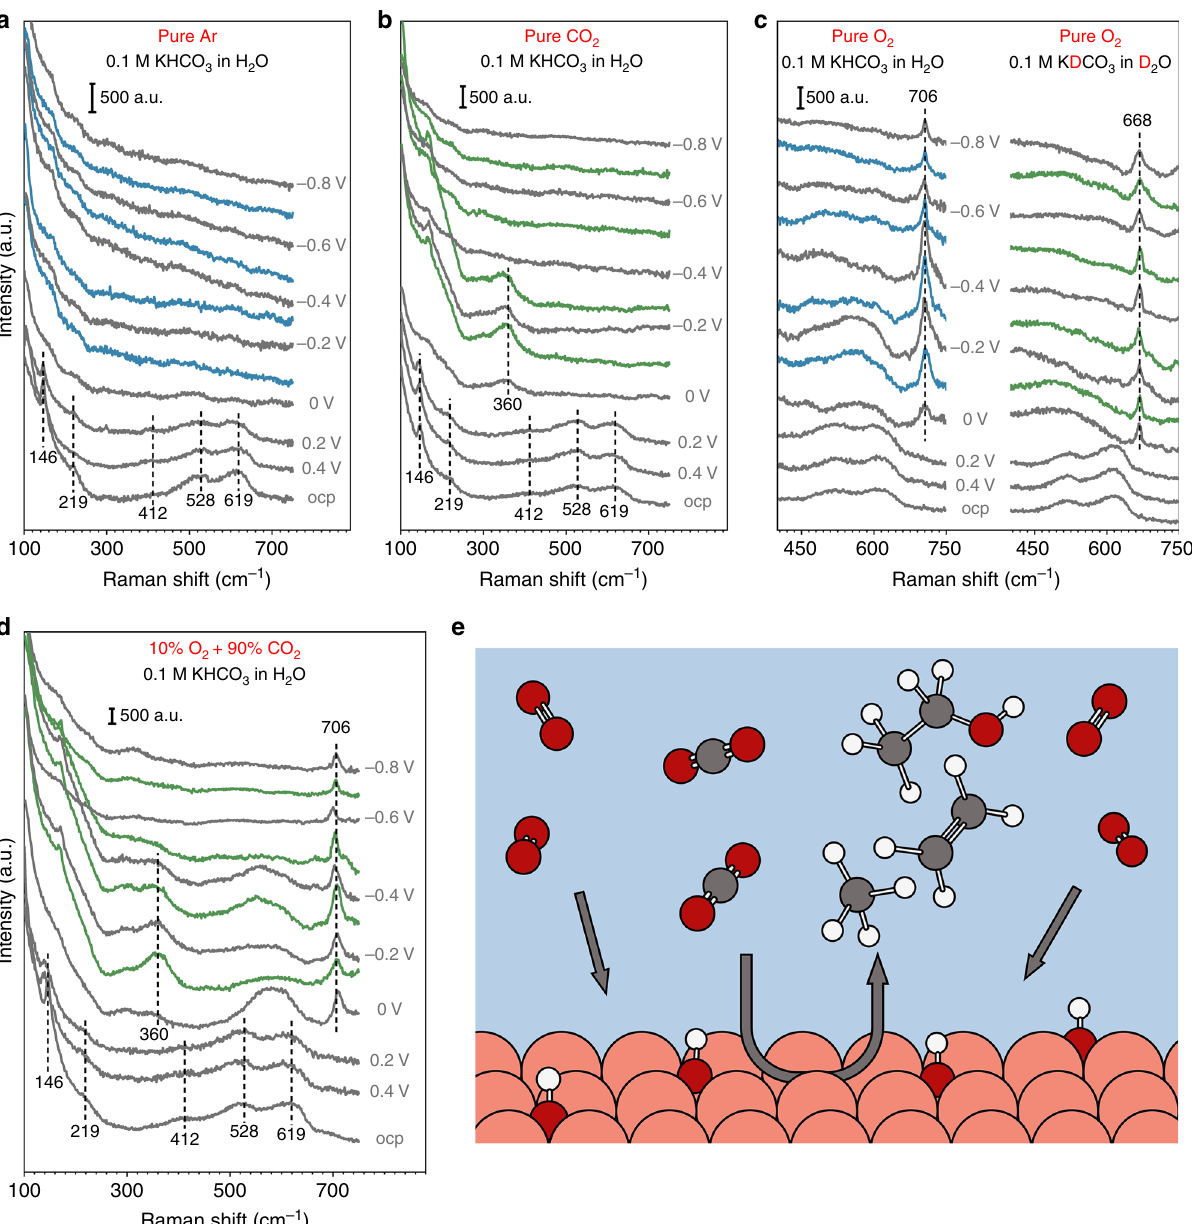
Fig. 3 In situ surface-enhanced Raman spectroscopy. Raman spectra of Cu catalyst at electrolysis with a pure Ar gas feed in 0.1 M KHCO 3 /H 2 O; b pure CO 2 gas feed in 0.1 M KHCO 3 /H 2 O; c pure O 2 gas feed in 0.1 M KHCO 3 /H 2 O and 0.1 M KDCO 3 /D 2 O; d 10% O 2 + 90% CO 2 in 0.1 M KHCO 3 /H 2 O. e Schematic of CO 2 RR on Cu surface at the presence of hydroxyl groups induced by